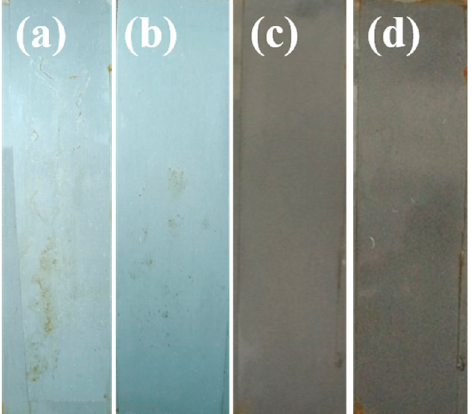
Figure 10. The morphology of coatings after NSS: ( a ) Al8-Ac15 after 72 h, ( b ) Ac8 after 72 h, ( c ) Ac8- Ac15 after 72 h and ( d ) Ac8-Ac15 after 96 h.